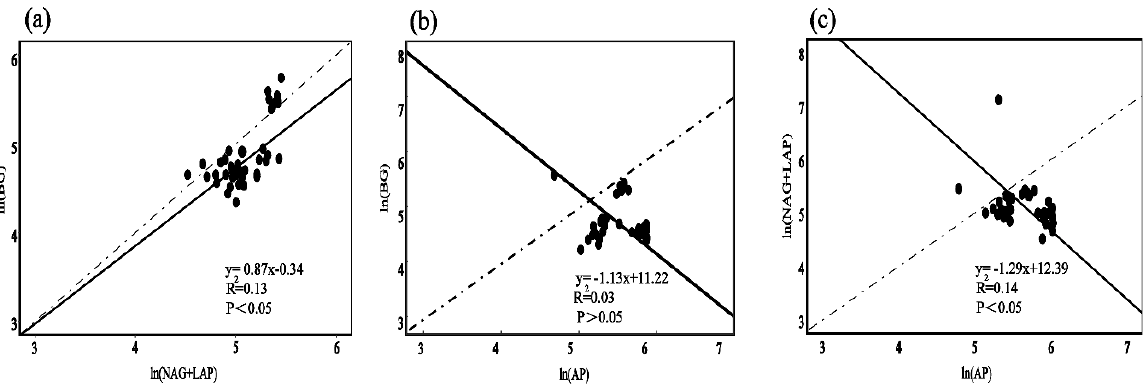
Figure 4. Standardized major axis regressions of the log-transformed soil C – , N – , and P – acquiring enzyme activities in different sites. C – acquiring enzyme activities (a), N – acquiring enzyme activities (b), and P – acquiring enzyme activities (c). Table 4. Length and angle of extracellular enzyme vectors in different subsurface soils.